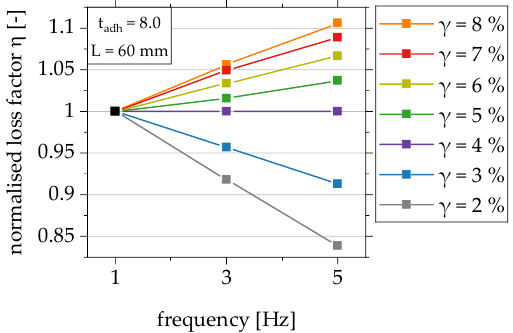
Figure 15. Analysis of the functional relationship between the shear strain level and the influence of the test frequency on the loss factor in the range of shear strain of the adhesive layer from 2% to 8% for overlap joint configuration 3 with overlap length 60 mm; plot normalised to the frequency 1 Hz [22].